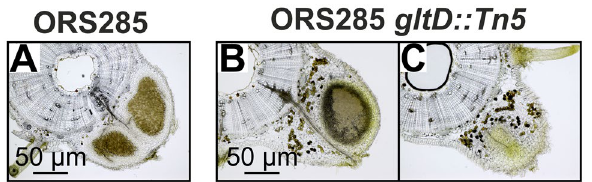
Figure 8. A. afraspera nodules induced by the Bradyrhizobium ORS285 gltD::Tn5 mutant contain many plant cells with a gold-brown substance. 70 µM nodule sections of A. afraspera plants inoculated with ( A ) wild-type ORS285 and ( B ), ( C ) ORS285 gltD::Tn5 mutant. Note the abundant presence of plant cells containing a gold- brown substance in nodule sections of plants inoculated with the ORS285 gltD::Tn5 mutant